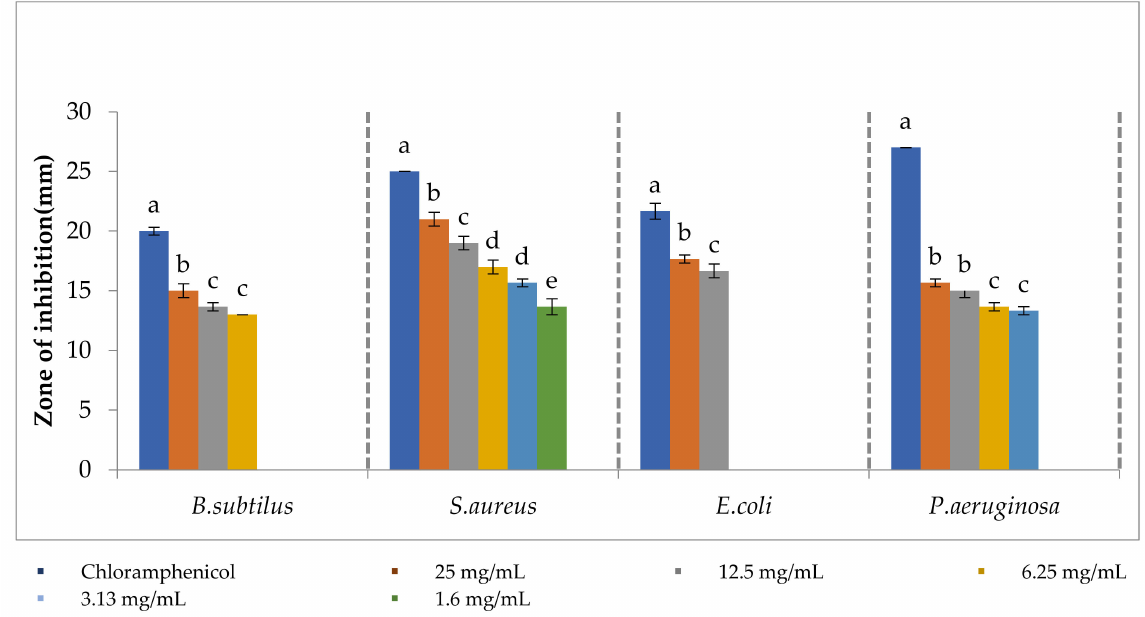
Figure 11. Antibacterial activity of nanoparticle (nw) synthesized from aqueous extract of aerial parts of Aerva javanica against pathogenic strains Bacillus subtilis , Staphylococcus aureus , Escherichia coli , and Pseudomonas aeruginosa at different concentrations. Different letters are indicating significant differences ( p < 0.05) among